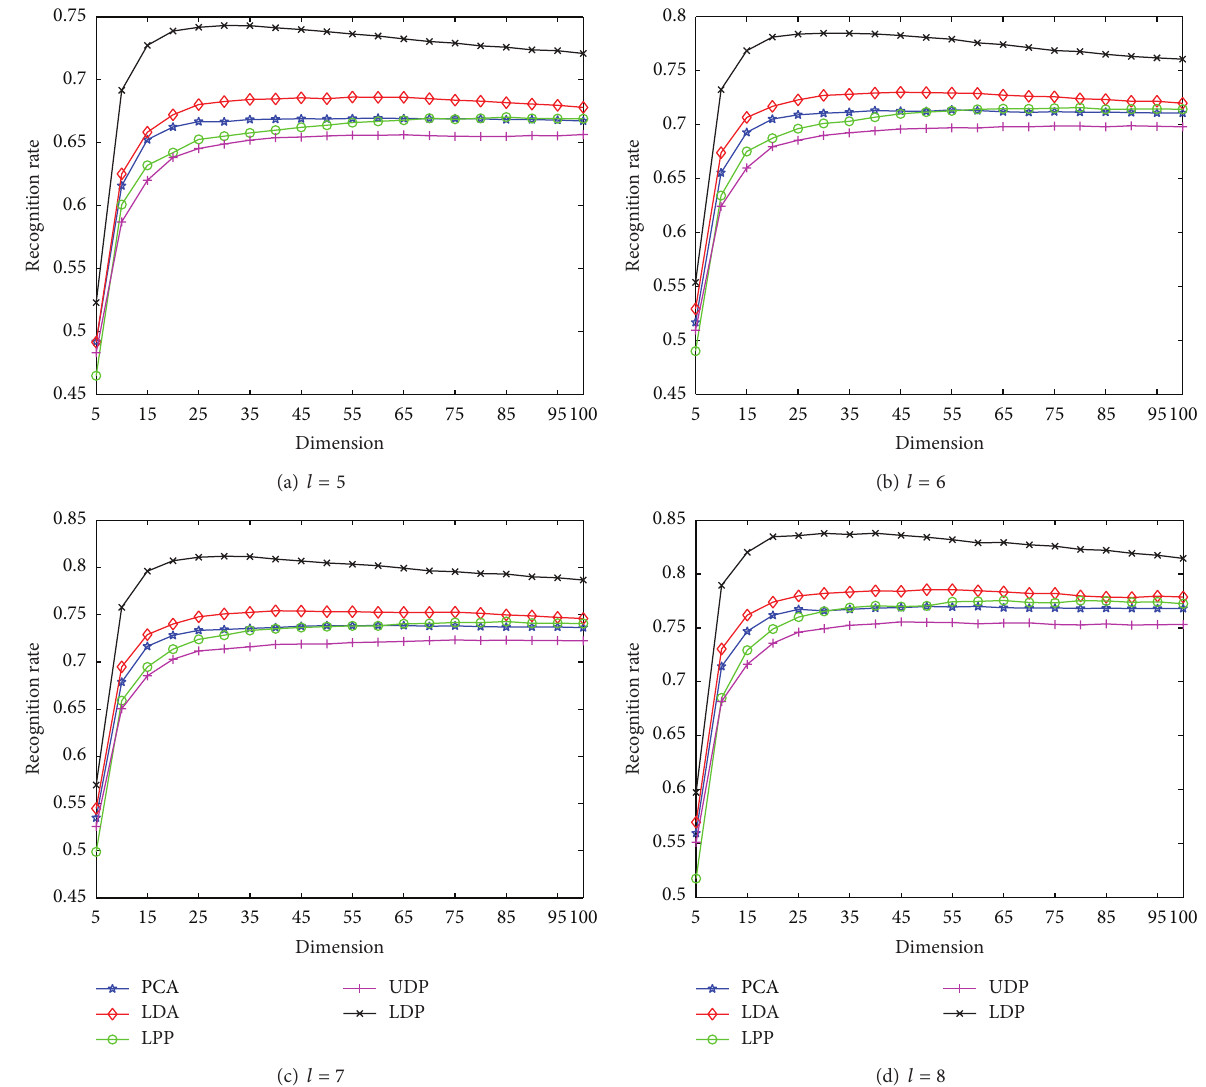
Figure 3: The average recognition rates versus dimension on HRF.